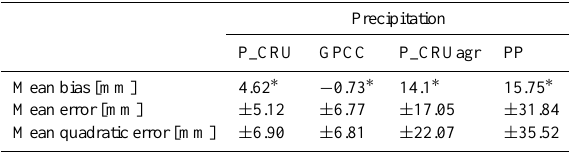
Table 3. Statistical evaluation of the differences between the ob- served and modeled data of monthly and seasonal precipitation to- tals ( ∗ significant value at α = 1%). P18 data set is used as reference